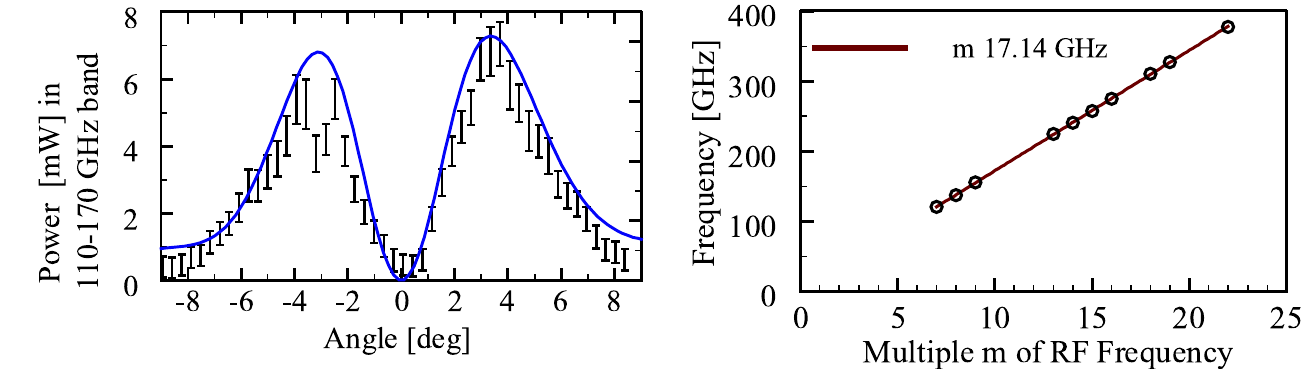
FIG. 4. (Color) Angular distribution of CTR power measured by the diode with error bars, and theory calculations made with EFIE code, shown by the solid line. The angular error on each data point is (cid:6) 0 : 2 degrees.